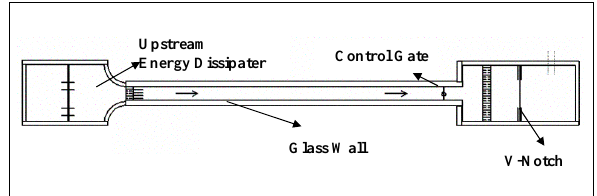
Figure 2- A schematic of ripple dimension Fig. 2. A schematic of ripple dimension. located at the end of the flume and an electromagnetic flow meter at inlet pipe. An adjustable gate was installed at the downstream end of the flume for the adjustment of flow depth and velocity. A schematic diagram of the experimental facil- ity is shown in Fig.